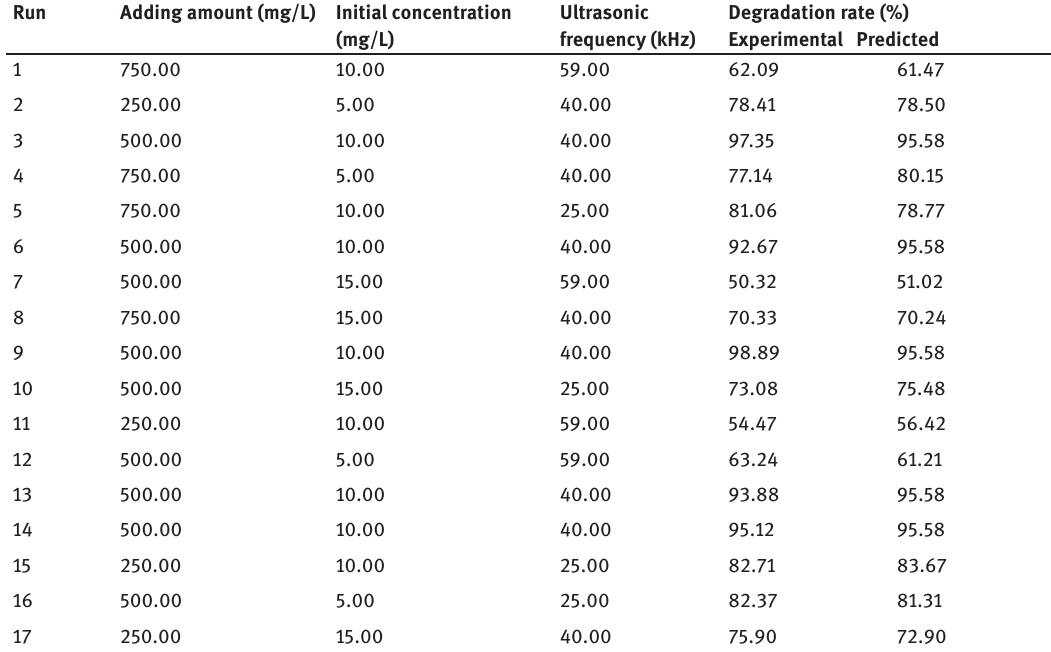
Table 3: The 3-factor Box-Behnken experimental design and the results for degradation rate of methyl orange. Run Adding amount (mg/L) Initial concentration